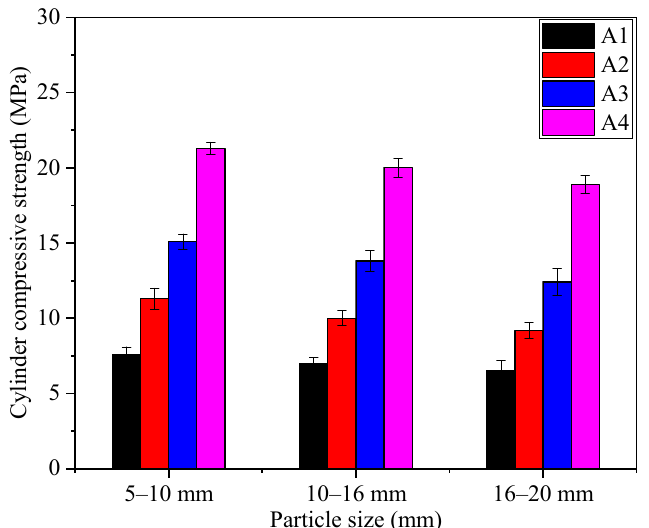
Figure 8. The influence of particle sizes on cylinder compressive strength.